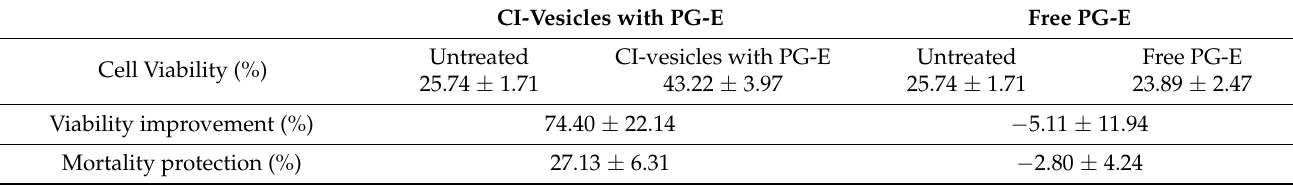
Table 5. The protection provided by free pomegranate extract (PG-E) and PG-E encapsulated in cauliflower vesicles (CI-vesicles) against heavy metals (1000 µ M lead acetate + 70 µ M mercuric chloride) in HaCaT cells. CI-Vesicles with PG-E Free PG-E Untreated CI-vesicles with PG-E Untreated Free PG-E Cell Viability (%) 25.74 ± 1.71 Viability improvement (%) 74.40 ± 22.14 Mortality protection (%) 27.13 ±